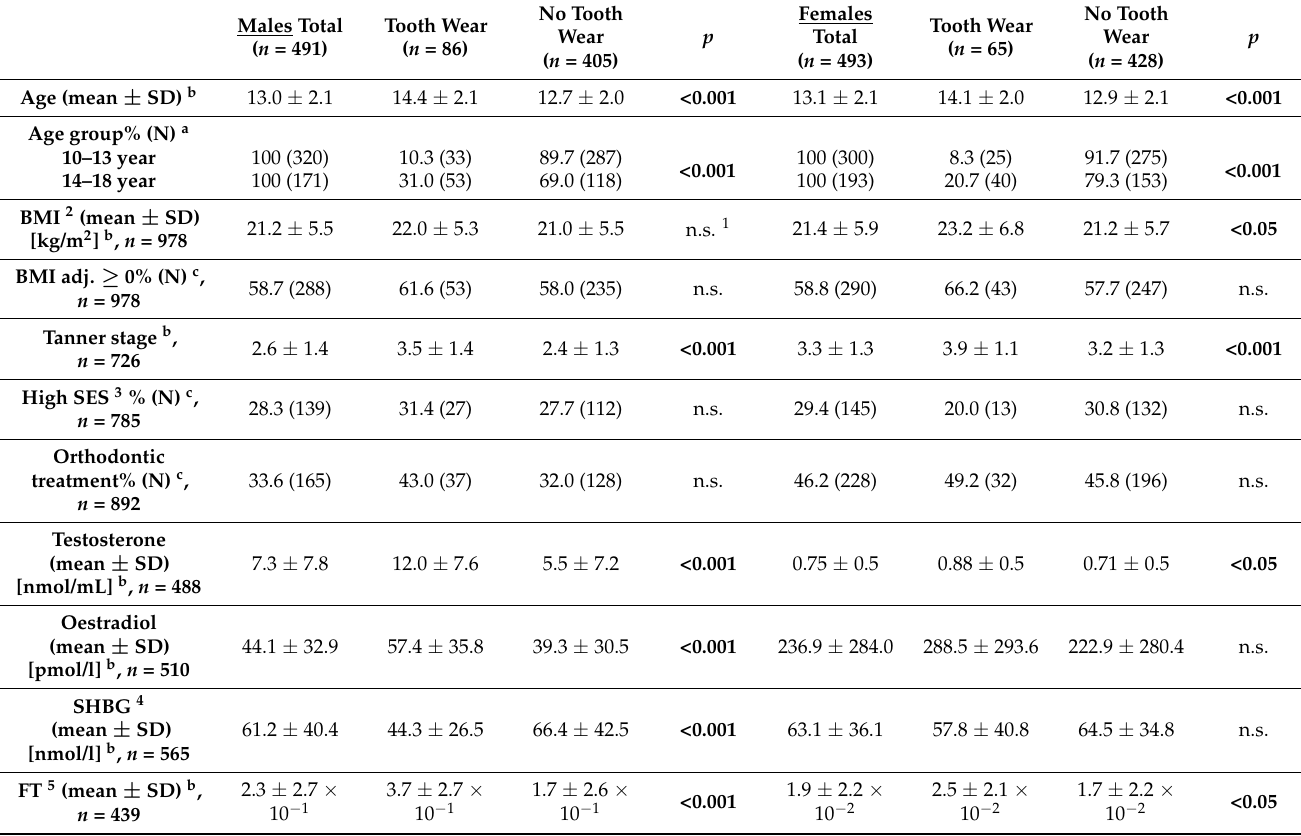
Table 1. Comparison of male and female subjects with or without tooth wear regarding influential variables, statistically significant values are in bold.